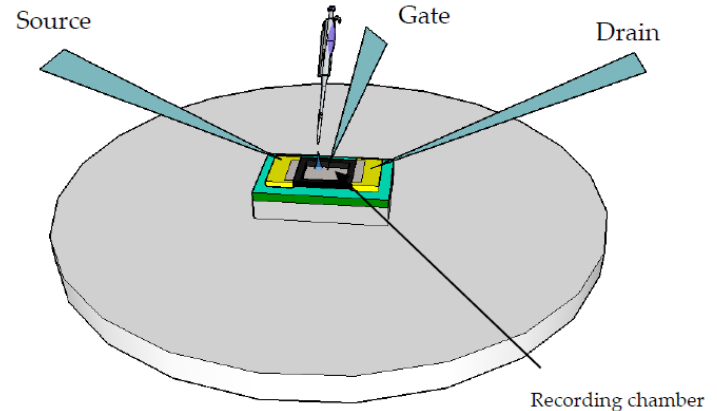
Figure 4. The schematic figure for the probe station with its three needles, contacting the source electrode, the drain electrode and the gate of the FET sensor, respectively.